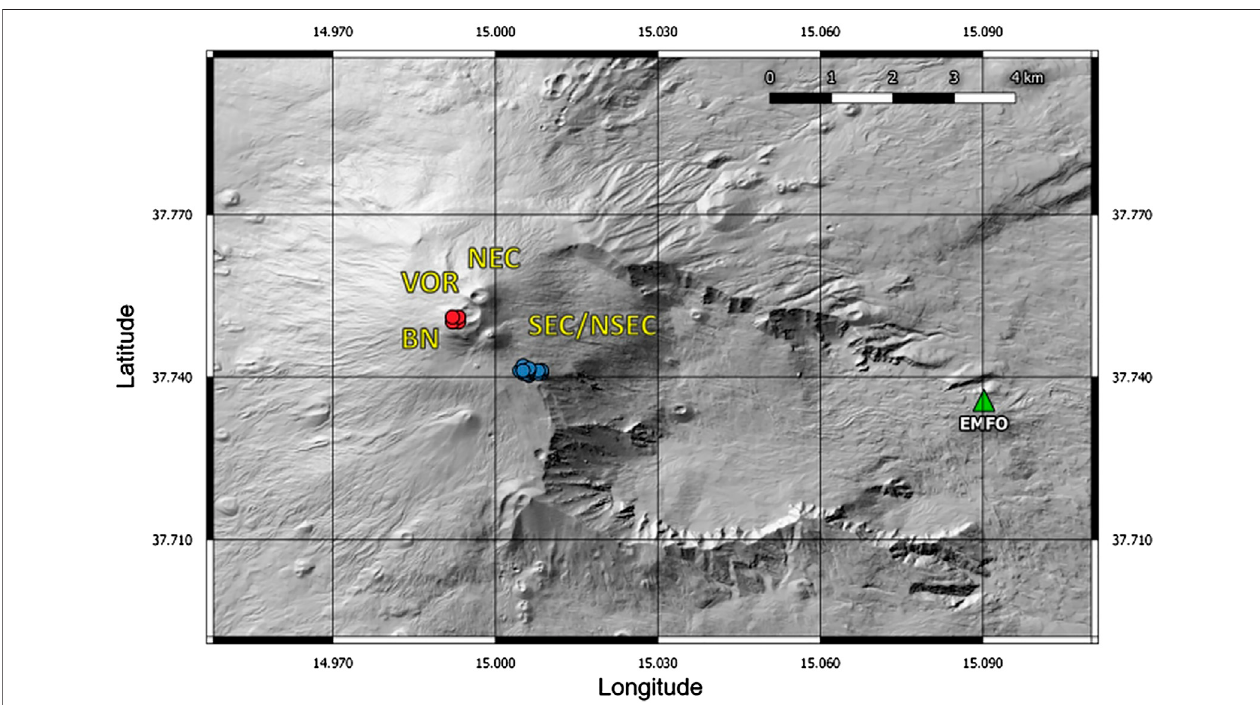
FIGURE 1 | Digital elevation model of Etna (Tarquini et al., 2007) with the location of the infrasonic station used in this work (green triangle EMFO), summit crater acronyms(VOR, Voragine;BN,BoccaNuova; NEC,North-EastCrater;SEC,South-East Crater;NSEC,New South-EastCrater),infrasonictremor sourcelocations(red circles) and infrasonic event source locations (blue